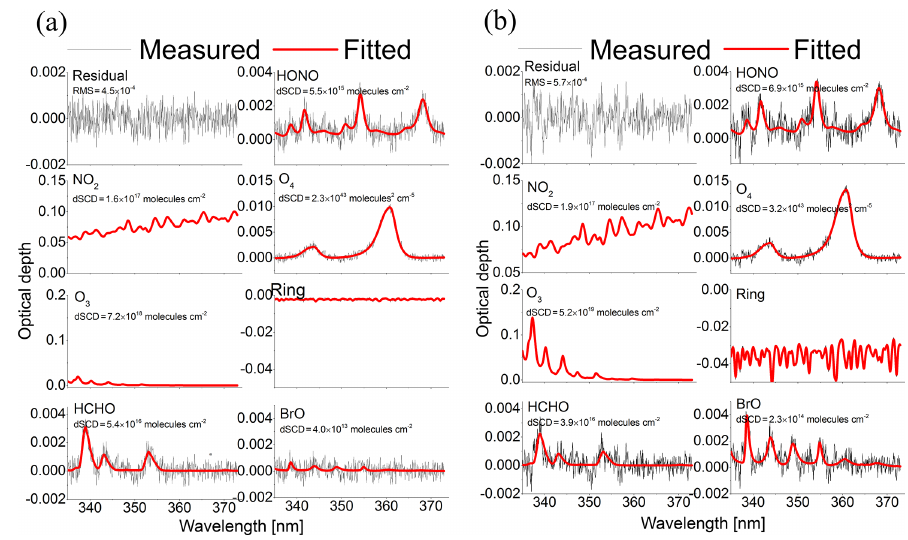
Figure 1. Examples of HONO fits of a spectrum acquired by the AIOFM instrument at around 04:00UTC on 18 June 2013 for 1 ◦ elevation angle and 50 ◦ azimuth angle. A sequential FRS around 03:58UTC (a) or a noon FRS around 11:30UTC (b) is